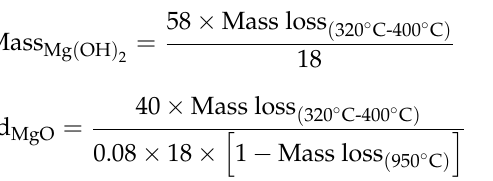
In the formula, Mass Mg and Hd MgO respectively represent the amount of Mg(OH) 2 ( OH ) 2 formed in the paste and the hydration degree of MgO. Mass loss (320 ◦ C–400 ◦ C) refers to the mass loss caused by the decomposition of Mg(OH) 2 in cement paste at 320–400 ◦ C or the mass loss caused by the blank sample of cement paste within this temperature range. Mass loss (950 ◦ C) indicates the mass loss of cement paste hardened at 950 ◦